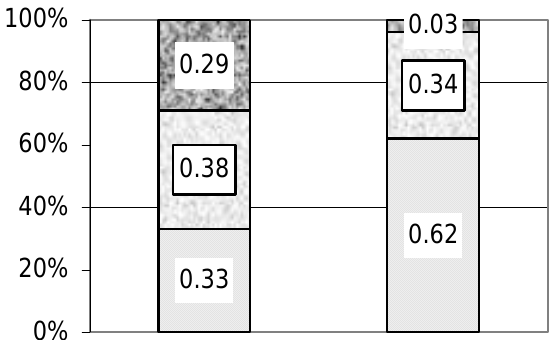
Column to the left represent Jews and the right Bedouins